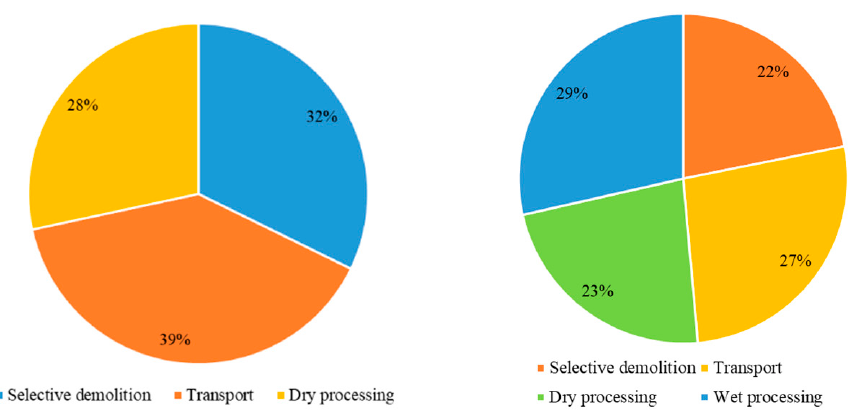
Figure 9. HotSpots GWP scenario B1 (stationary plant conventional) ( left ) and scenario B2 (stationary plant innovative) ( right ).